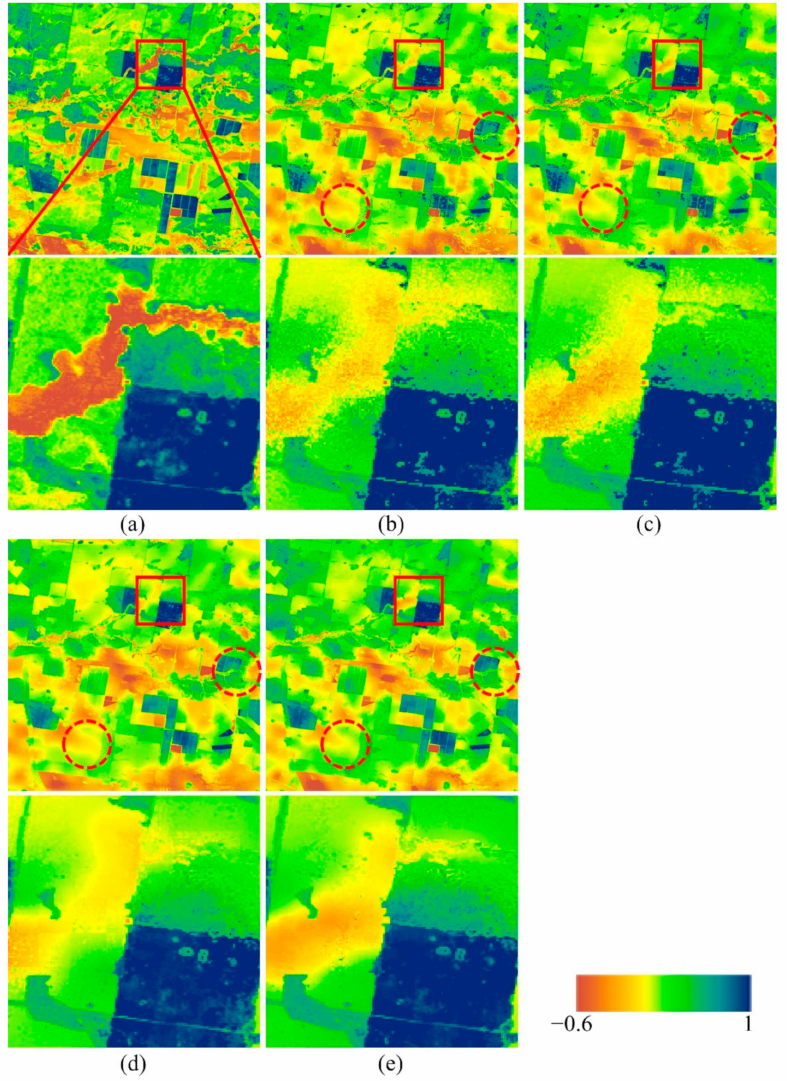
Figure 9. Landsat NDVI of the Gwydir site on 12 December 2004: ( a ) actual image, ( b ) image predicted by FSDAF, ( c ) image predicted by the bias-corrected FSDAF, ( d ) image predicted by the STARFM, and ( e ) image predicted by the bias-corrected STARFM.